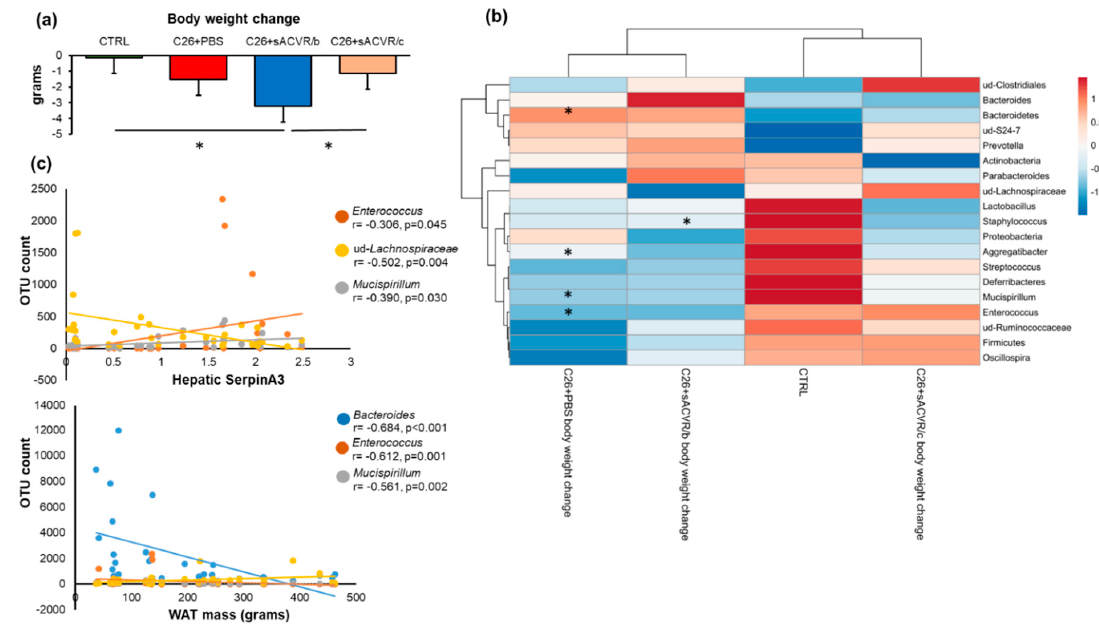
Figure 4. ( a ) The body weight change during the last three days before necropsy. ( b ) Several microbial phyla and genera were associated with the body weight loss, but not significantly in the CTRL and C26 + sACVR / c groups. In the heat map analysis using correlation distance and average linkage, the C26 + PBS and C26 + sACVR / b groups clustered together, indicating that the associations between body weight loss and the gut microbiota in the C26 + PBS and C26 + sACVR / b groups resembled each other and di ff ered from the CTRL and C26 + sACVR / c groups. The FDR-corrected significant associations and di ff erences between the groups in body weight change are marked with asterisks (*). The numeric colored scale bar at upright corner represents the Spearman correlation coe ffi cients. ( c ) The flagellated gut microbial taxa and their association with the cachectic features of hepatic expression of acute-phase response protein SerpinA3 and white adipose tissue (WAT) mass. Control (CTRL, n = 9), cancer (C26 + PBS, n = 7), the group that received sACVR2B until tumor formation (C26 + sACVR/b, n = 7), and the group that received sACVR2B until death (C26 + sACVR/c, n = 8).